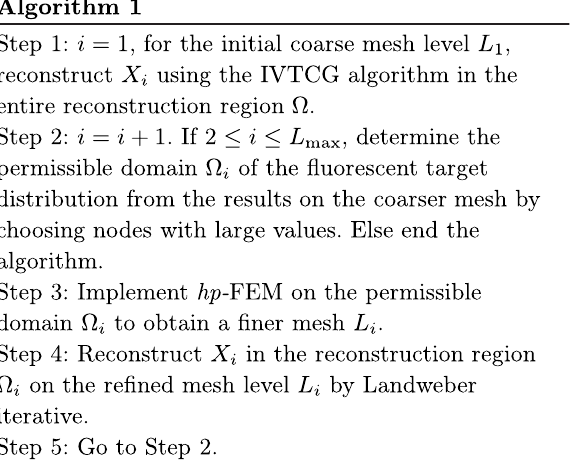
gradient algorithm (IVTCG) 23 :